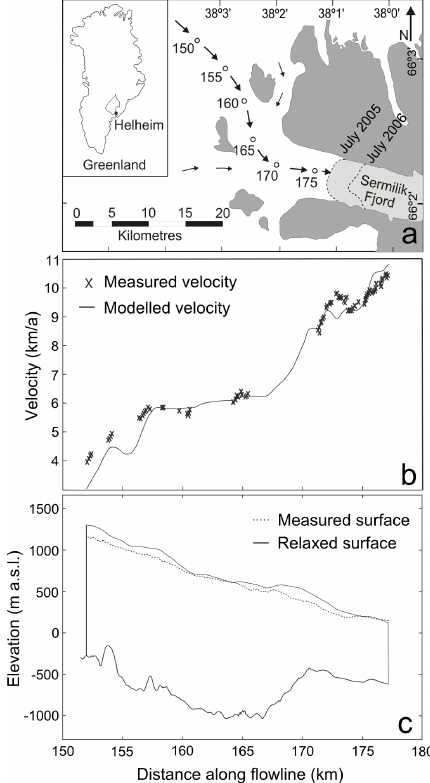
Fig. 1. Model set-up. (a) Location of Helheim Glacier, with path of chosen flowline and two indicative terminus positions. Numbers in- dicate distance along flowline in km. (b) Comparison of measured and modelled surface velocity at end of spin-up. (c) Comparison of observed surface profile with relaxed surface profile used to initial- ize